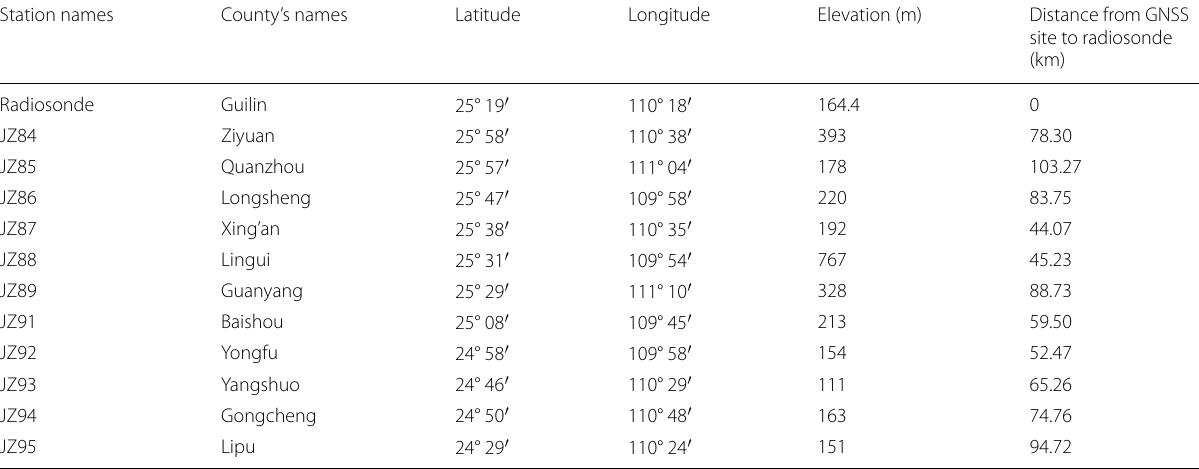
Table 1 Details of the information on GNSS and radiosonde stations in Guilin Station names County’s